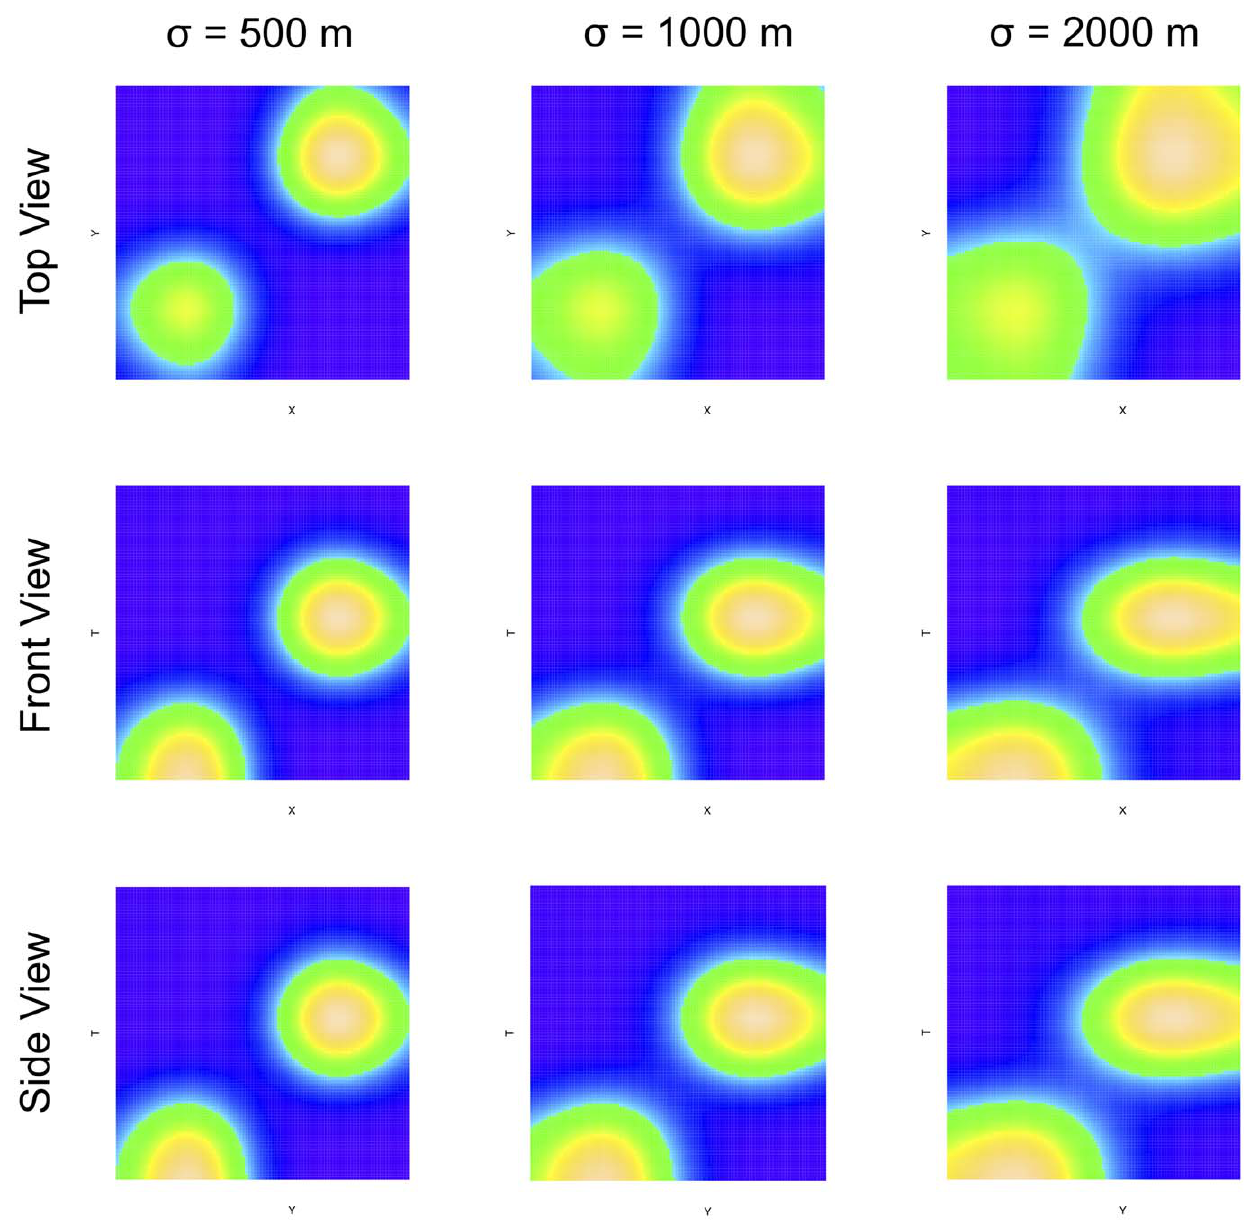
Figure 1. Intensity of the three simulated event patterns. Each panel shows a different perspective of a space-time cube for the three patterns. The left most column corresponds to the high intensity cluster pattern (where cluster events are concentrated in a smaller area) and the right-most column corresponds to the lowest intensity pattern. The top row shows an areal view of the space time cubes (i.e. a conventional map), the middle row shows a front view of the cubes, while the bottom row shows a side view. Lighter areas indicate a higher intensity of events.